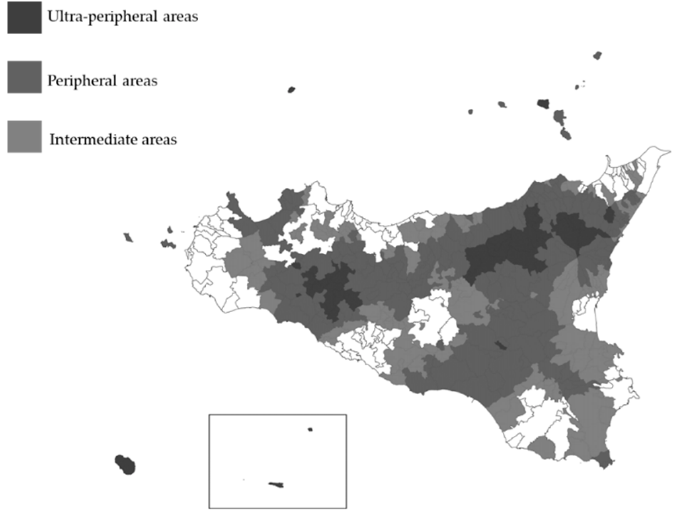
Figure 4. NSIA classification for inland areas of Sicily. (Authors’ elaboration based on NSIA data.) They are characterized by 14 “pole” municipalities (4% of the total), 65 “belt” (17% of the total), 119 “intermediate” (31% of the total), 157 “peripheral” (40% of the total) and 34 “ultra-peripheral” (9 percent of the total). Intermediate, peripheral, and ultra- peripheral areas account for 80% of those falling under this classification. These areas cover a territory with an area of 19,541 square kilometers, in which 2,312,007 inhabitants reside. The percentage of municipalities falling in the NSIA classification (Figure 5) for the different metropolitan cities shows a greater concentration of the ultra-peripheral, peripheral, and intermediate typology for Messina, the absence of municipalities in the ultra-peripheral typology for Caltanissetta and Syracuse, and of municipalities falling in only intermediate areas for Ragusa.